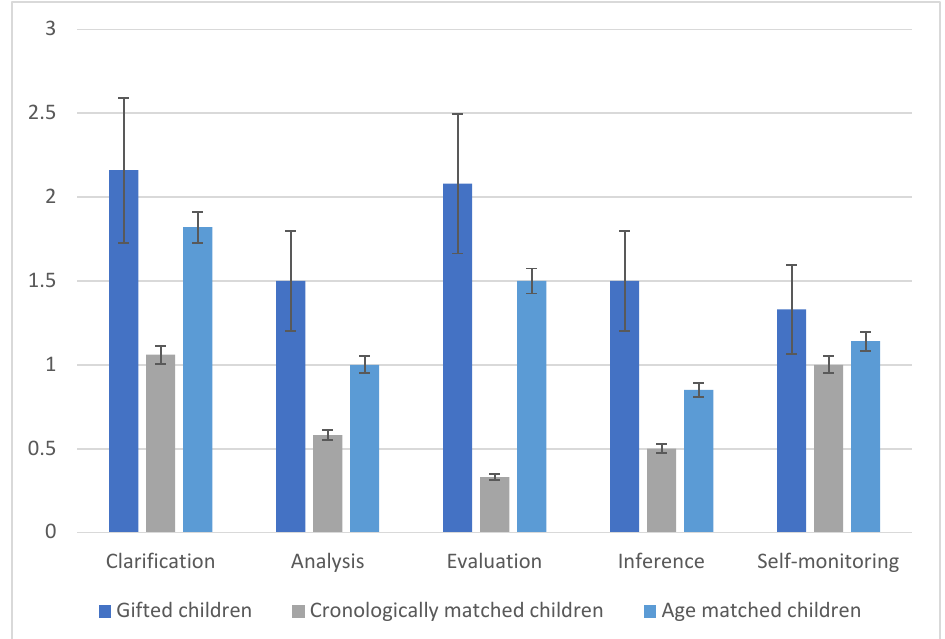
Figure 1. Means of the correct performance on the five phases of neutral critical thinking.